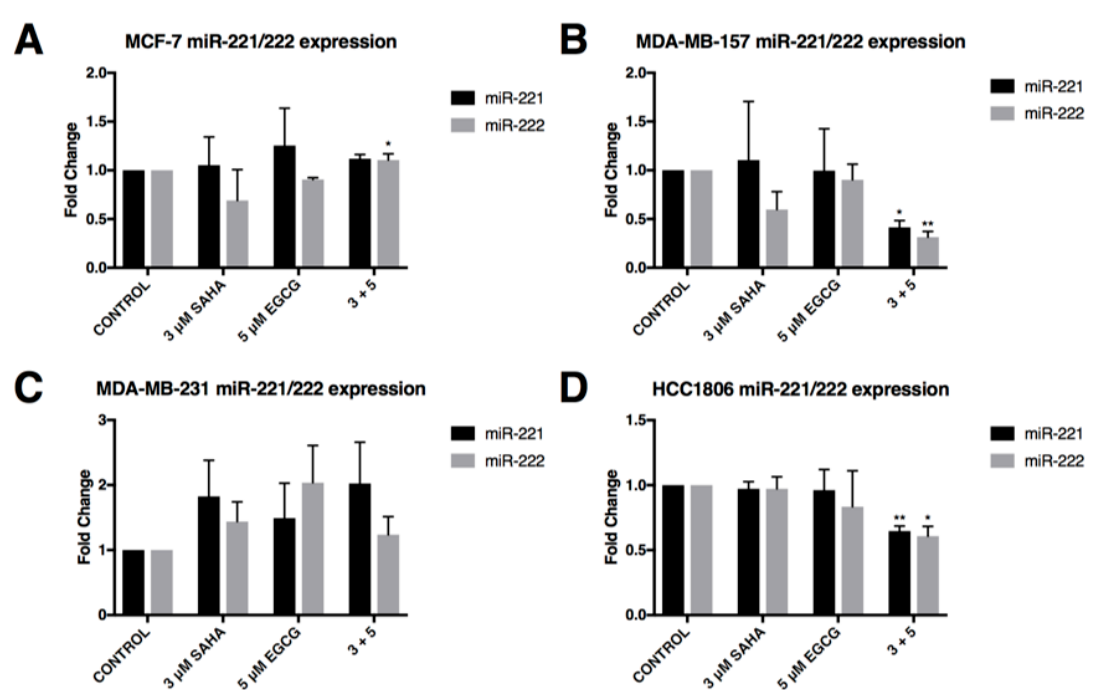
Figure 3. In combination, SAHA and EGCG significantly reduce the expression of miR-221/222 in two triple-negative breast cancer cell lines. ( A ) qRT-PCR was completed using MCF-7 cells after 3-day treatments with the indicated compounds using miR-221 and miR-222 primers ( n = 3). RNU6B was used for comparison; ( B – D ) the same was done in MDA-MB-157, MDA-MB-231, and HCC1806 cells ( n = 3). Error bars represent standard error of the mean (SEM); * p < 0.05, ** p < 0.01.